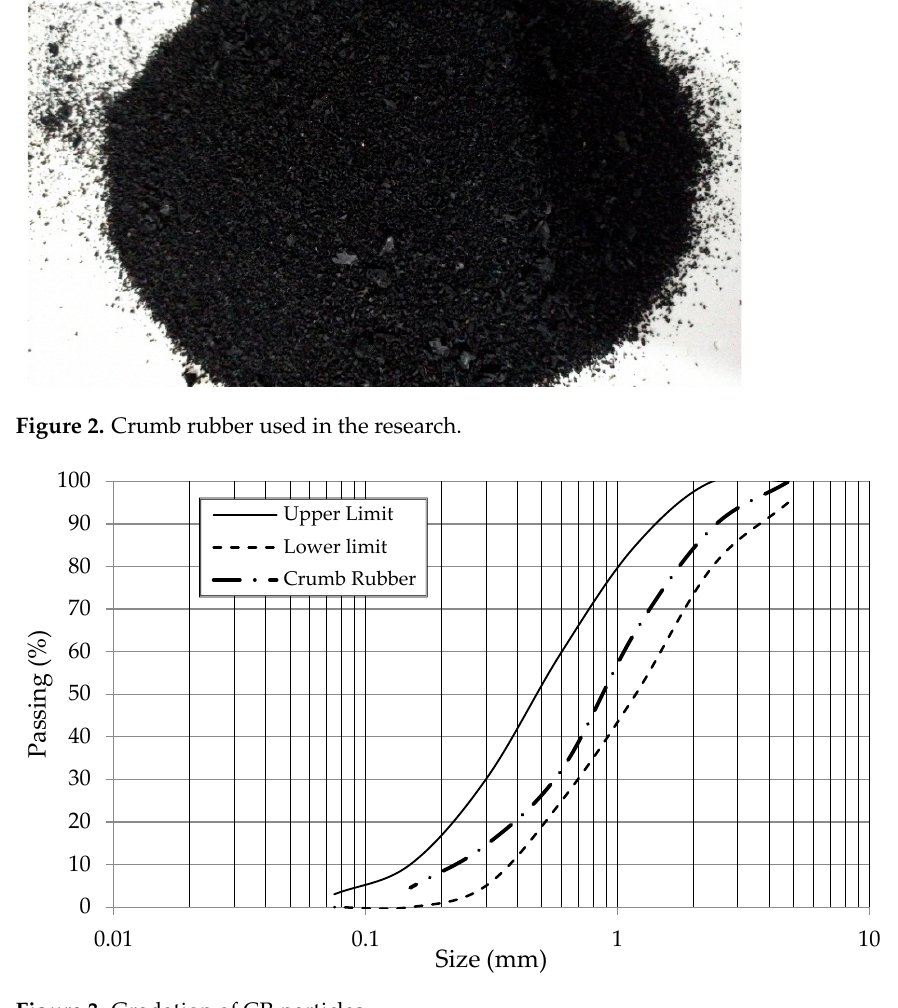
Figure 3. Gradation of CR particles.